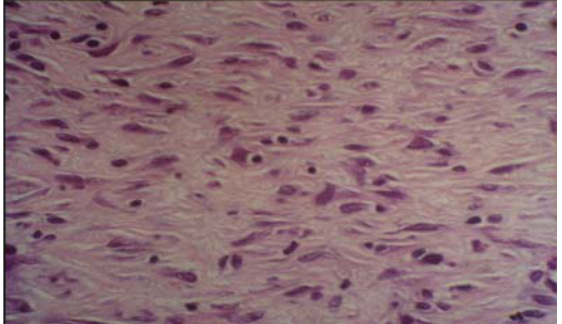
FIGURE 2 - Photomicrograph of the rat skin day 21 after peeling using TCA, in the control group (G1) (HE, 100X), fibroblasts with circular and oval nuclei,dissociated fibers.